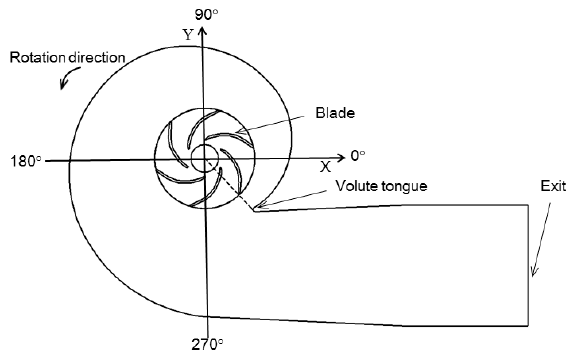
Figure 2. Mid-plane view of the inner fluid region of the pump.